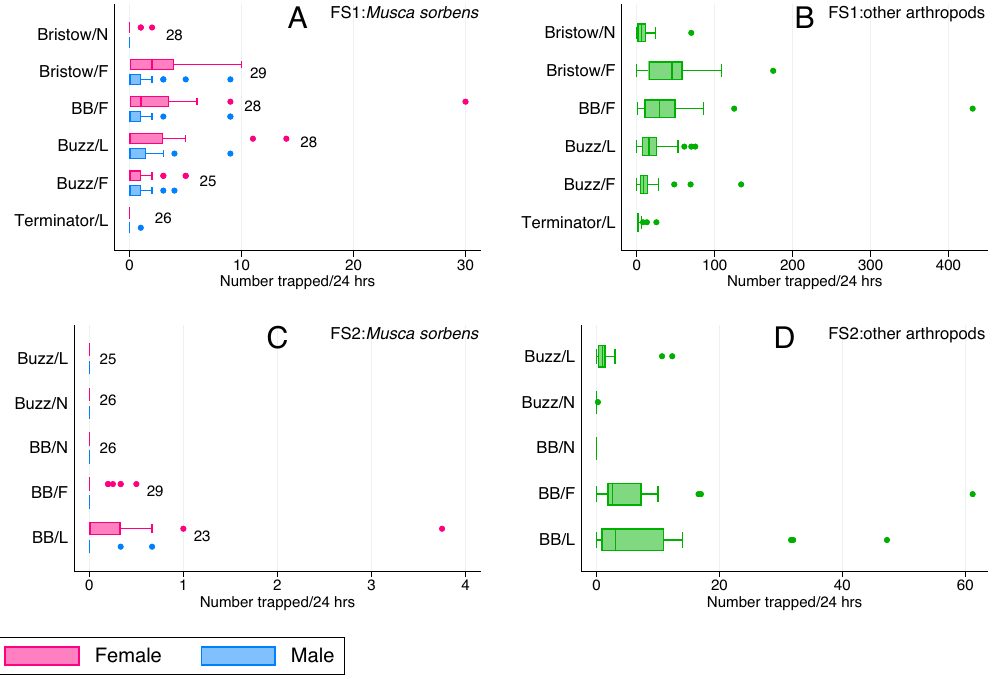
Figure 2. Male and female M. sorbens ( A / C ), and total ‘other arthropods’ ( B / D ) caught by different trap designs in field studies one (FS1) and two (FS2) (boxes, median and interquartile range; points, outliers). Trap abbreviations are: Bristow/N Bristow trap/no bait, Bristow/F Bristow trap/faeces bait, BB/F Bickford bucket/ faeces bait, Buzz/L Buzz trap/Buzz lure, Buzz/F Buzz trap/faeces bait, Terminator Terminator trap/terminator lure, Buzz/N Buzz trap/no lure (water), BB/N Bickford bucket/no lure (water), BB/L Bickford bucket/lure (Buzz). Trap events per trap type given as data labels in ( A ) and ( C ); those are equal for ( A / B ) and ( C / D ). In FS2 trap events were approximately 72 h; data shown is per 24-h